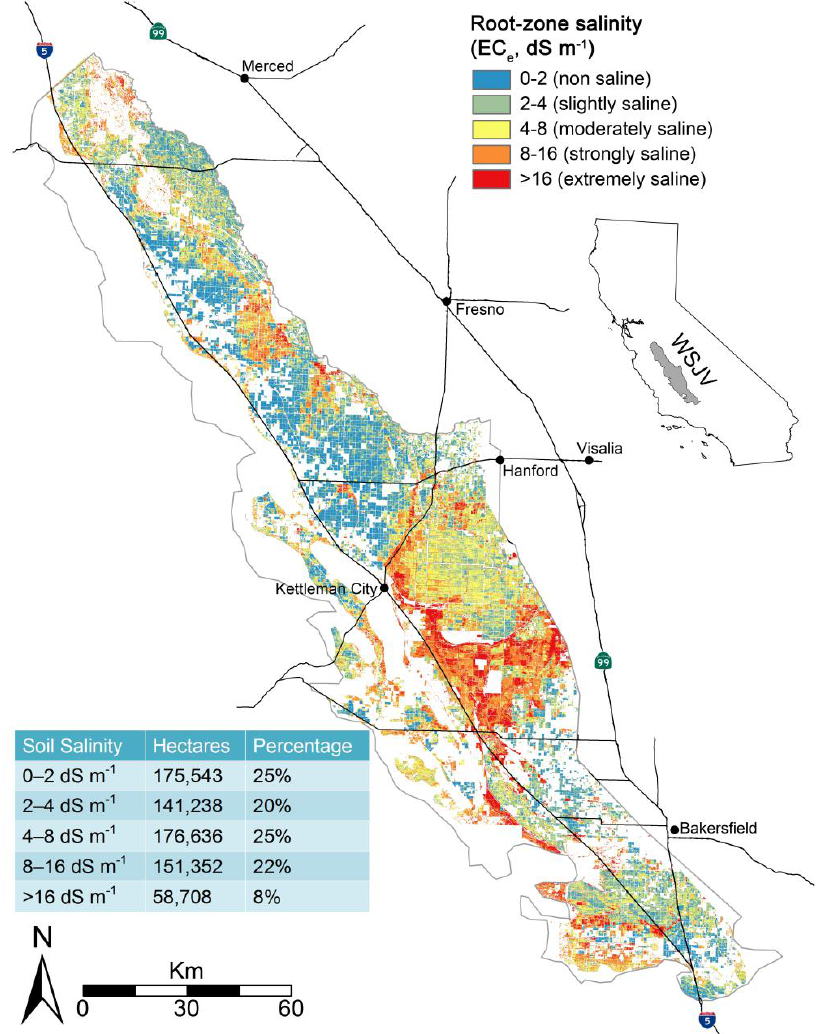
Figure 7. Map of salt-affected soils for the west side of California’s San Joaquin Valley